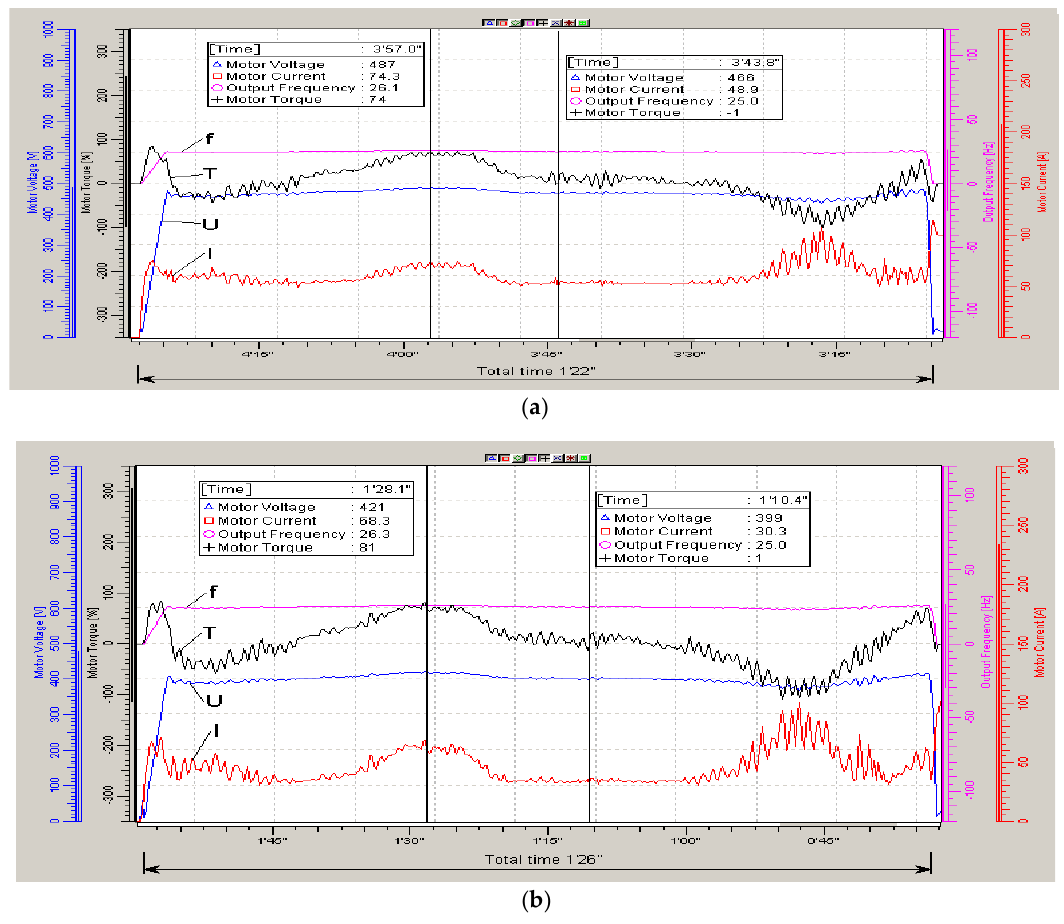
Figure 4. Diagrams of movement along track 2 ( a ) Medium speed with parameters U = 468 V, f = 25 Hz and U/f = 18.7 Fl ( b ) Medium speed with parameters U = 400 V, f = 25 Hz and U/f = 16 Fl.